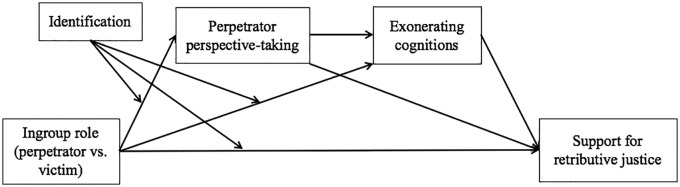
Moderated serial multiple mediator model (Process 3.0, Model 85) depicting the indirect effect of ingroup role on support for retributive justice through perpetrator perspective-taking and exonerating cognitions, moderated by national identification (Study 2).